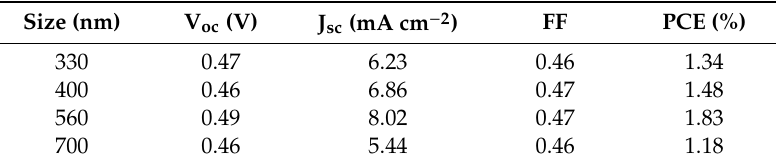
Figure 5. Current density-voltage (J-V) curves of QDSSCs based on ZnS / CdS@TiO 2 HMS with size ~330 nm, ~400 nm, ~560 nm, and ~700 nm, respectively. Table 1. Size e ff ect of TiO 2 HMS on photovoltaic performance of ZnS / CdS